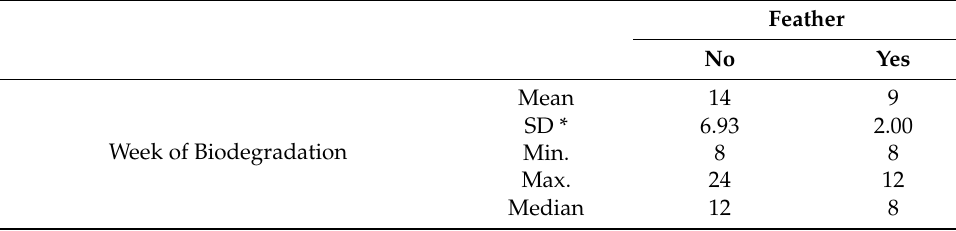
Table 4. The results obtained by the ANOVA test for the samples in Group II.